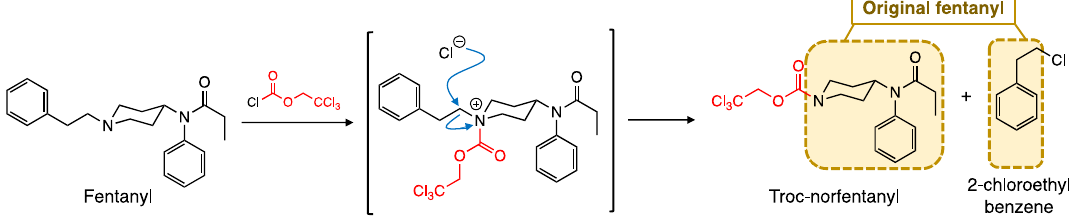
Figure 2. Outline of derivatization strategy described in this work. Treatment of a fentanyl with TrocCl results in an intermediate that undergoes a chloride-mediated dealkylation to furnish two products: Troc-norfentanyl and 2-(chloroethyl)benzene. The dashed boxed sections in both products can be retrospectively joined to reveal the identity of the original